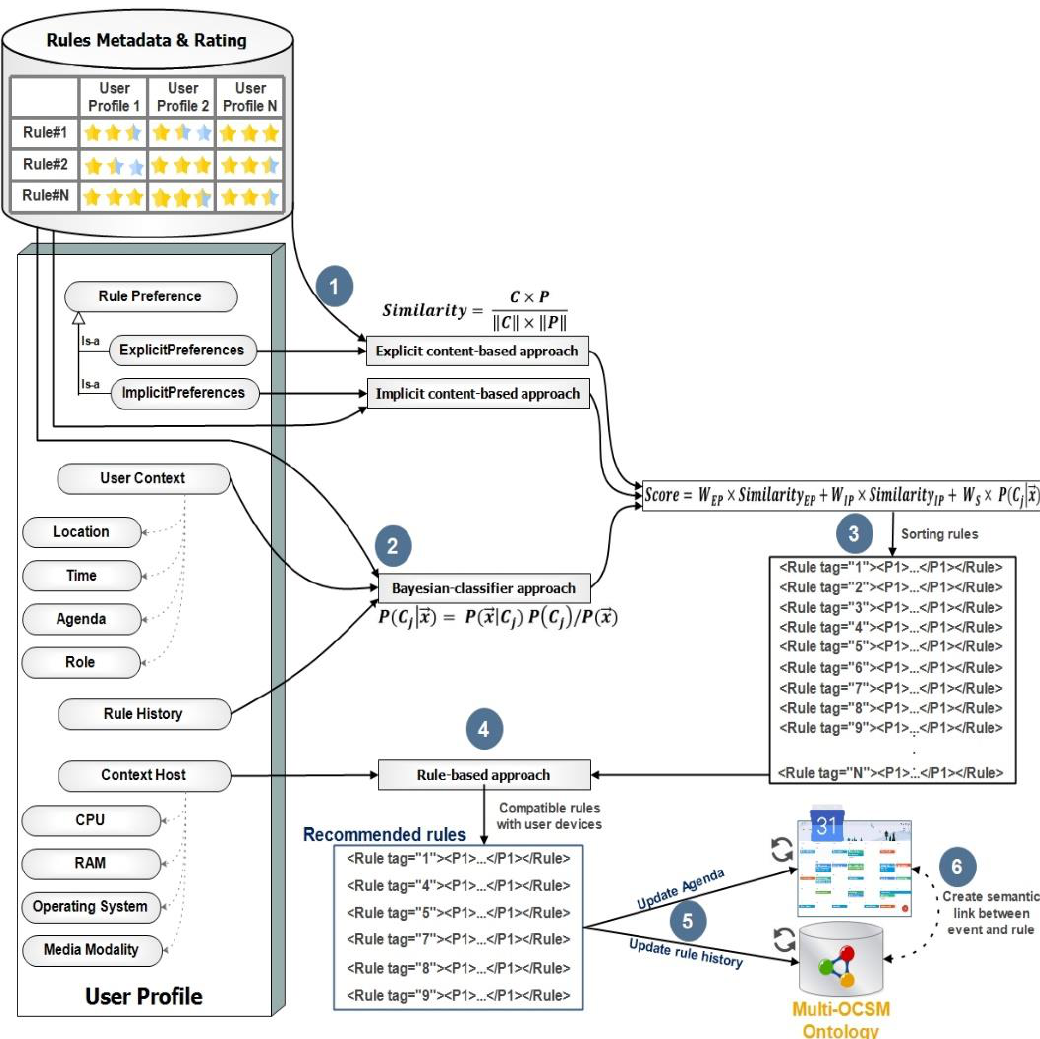
Figure 4. Hybrid rule-based recommendation process.